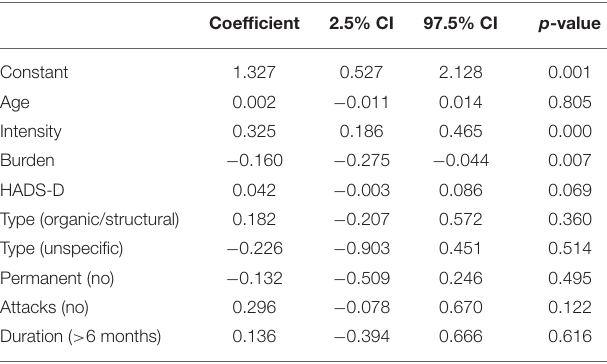
TABLE 2 | Elastic net regularization with tolerance as a dependent variable.